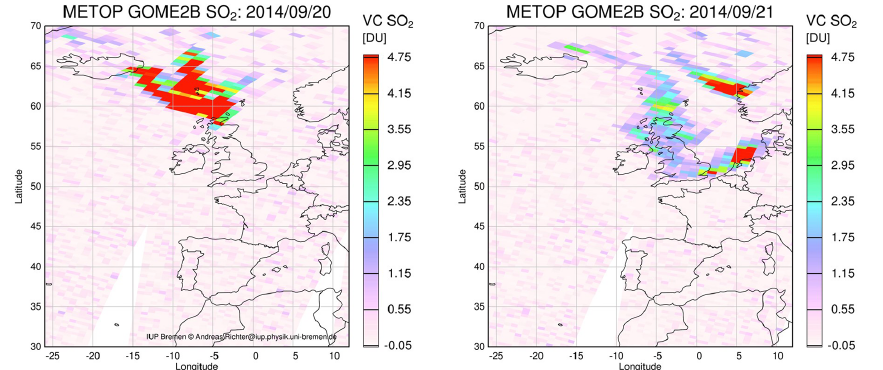
Figure 3. Observation of the volcanic plume from Iceland to and across the UK by the GOME2B satellite instrument, taken at the satellite overpass around 09:30 local time. GOME2B measures SO 2 column density, where VC is the vertical column, which is the SO 2 concentration integrated vertically to provide a column density per unit surface area. SO 2 columns are given in Dobson units (DU); the thickness the SO 2 layer would have at standard temperature and pressure is in units of hundredths of a